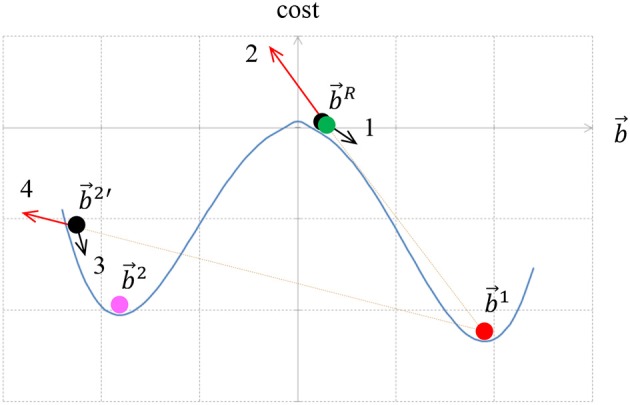
The method for finding multiple local minima of a functional. We start from a random particle b⃗R (green) and reach a minimum at b⃗1 (red). The force that is responsible for moving the particle from b⃗R is caused by the cost functional (arrow 1 black). The particle b⃗1 is then replaced by an immovable repulsive particle at the same location. When the process is restarted with a new particle from b⃗R (black), the repulsive particle at b⃗1 pushes the particle at b⃗R (red arrow 2) toward a new minimum b⃗2. However, due to the repulsive force (red arrow 4) the particle is pushed beyond the new minimum b⃗2, and arrives at location b⃗2′ (black). To find a local minimum, which is not influenced by the repulsive particle, the repulsive particle at b⃗1 is removed and a new minimum search starts from b⃗2′. This particle is pushed to a new minimum at b⃗2 (magenta) by the cost functional force (arrow 3 black).